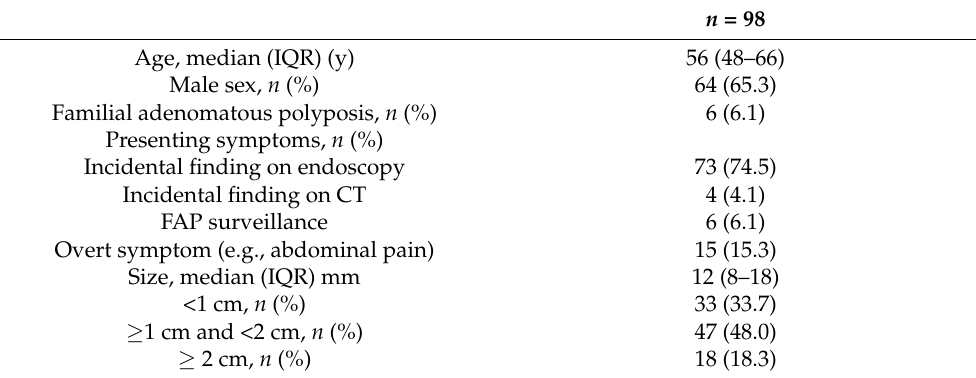
Table 1. Baseline characteristics of the included